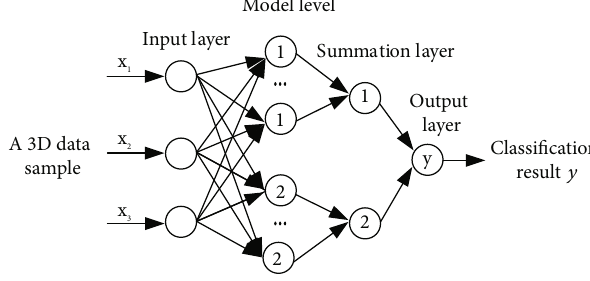
Figure 5: Structure diagram of a